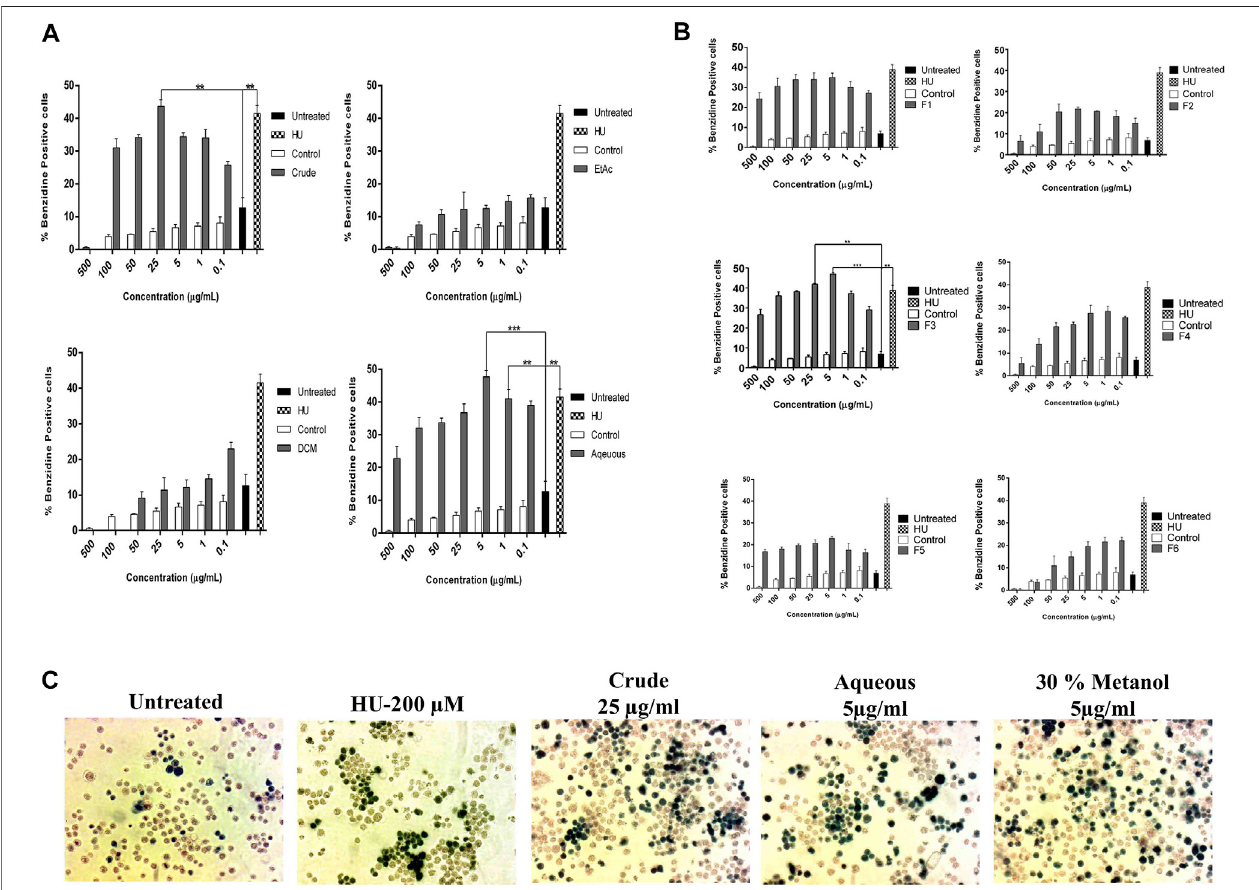
FIGURE 1 | Bioassay-guided activity of A. vasica on erythroid differentiation of K562 cells assayed by benzidine – Hb staining. (A) The HbF induction activity of the crude, DCM, EtOAc, and aqueous extracts. (B) K562 cells were treated with six sub-fractions (F1 – F6) for 5 days to evaluate the inducing effects. Data is obtained from three independent experiments in triplicate and shown as mean ± SEM; * p < 0.05 vs . control. (C) Microscopic images of treated cultures showed differentiating benzidine-positive (induced cells) uninduced K562 cells.